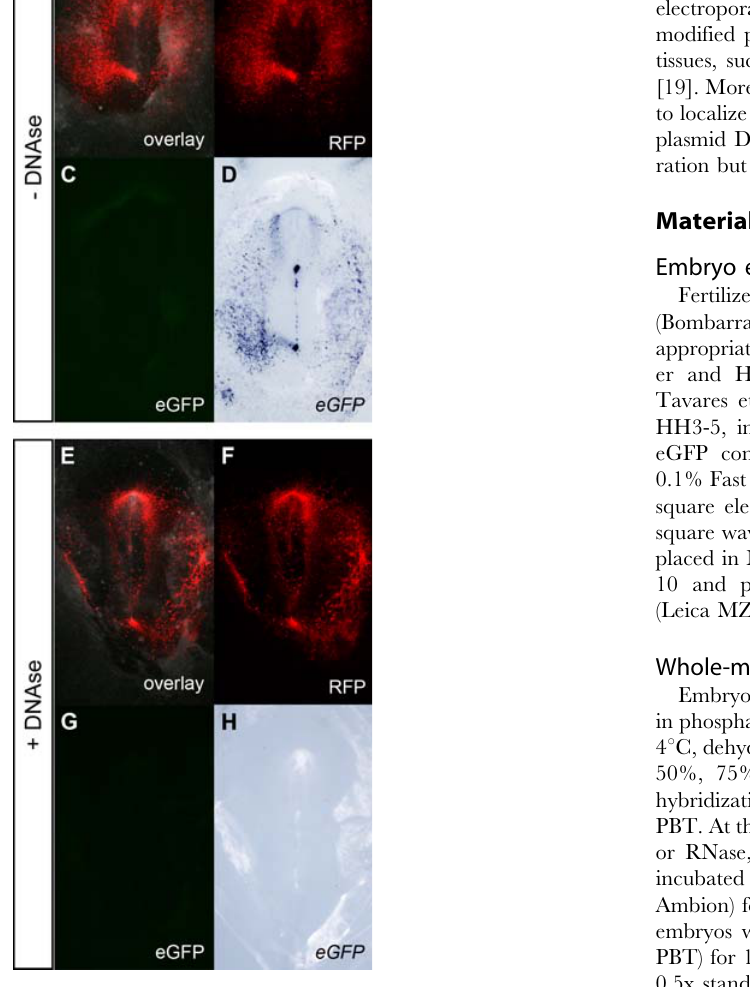
Figure 3. Comparison between eGFP fluorescence and eGFP expression patterns in Cer0.12-eGFP/CAGGS-RFP electroporat- ed chick embryos. Chick embryos were co-electroporated with Cer0.12-eGFP (silent reporter) and pCAGGS-RFP (ubiquitous reporter) at stage HH3 and processed for WISH. (A, E) Merge of bright field with fluorescence images. (B, F) RFP fluorescence. (C, G) eGFP fluorescence. (D, H) WISH using the eGFP antisense probe. At stage HH6, RFP fluorescence was observed throughout the electroporated embryos, whereas eGFP fluorescence was undetectable. After WISH, the eGFP probe was detected in untreated embryos (D) but not in DNase I- treated embryos (H).